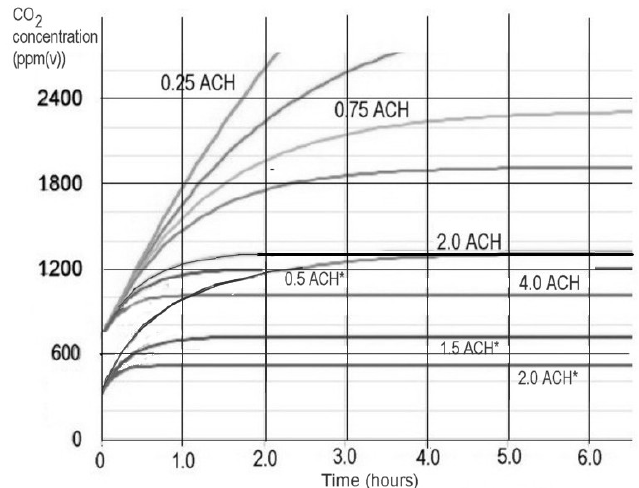
Figure 4. Of CO 2 above outdoors levels with two people in the contaminated building (ACH—air change rate) and in a typical clean office room (ACH*).